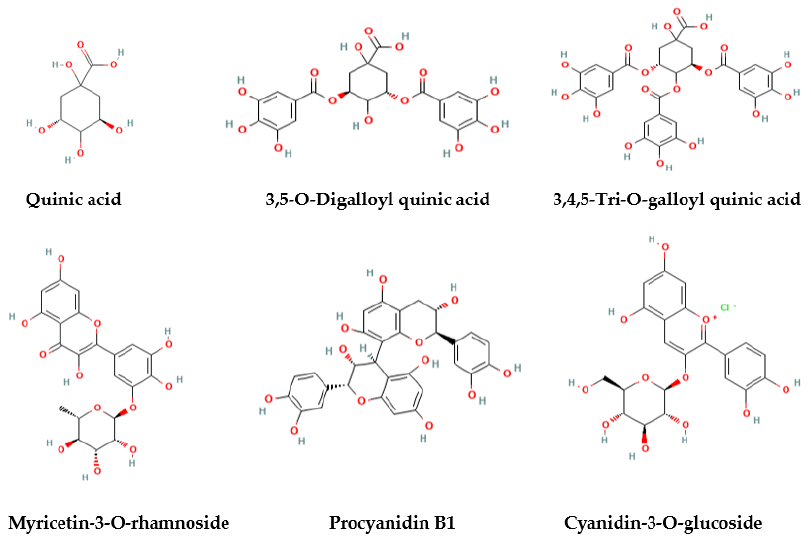
Figure 1. Structure of major phenolic acids and flavonoids detected in P. lentiscus extracts.